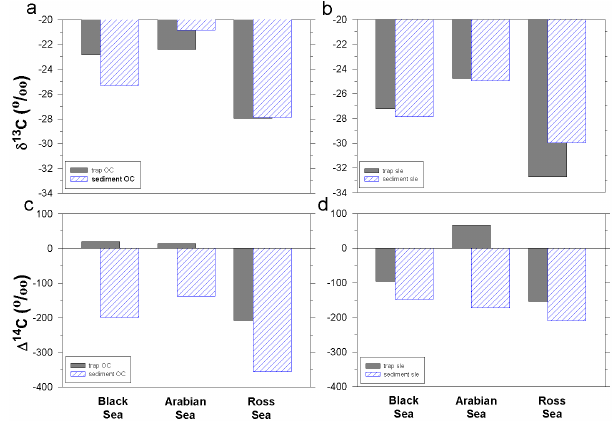
Figure 4. (a) The δ 13 C and (b) (cid:49) 14 C values of bulk organic carbon (OC) and (c) δ 13 C and (d) (cid:49) 14 C values solvent extractable lipids (SLE) for trap POM and sediments.